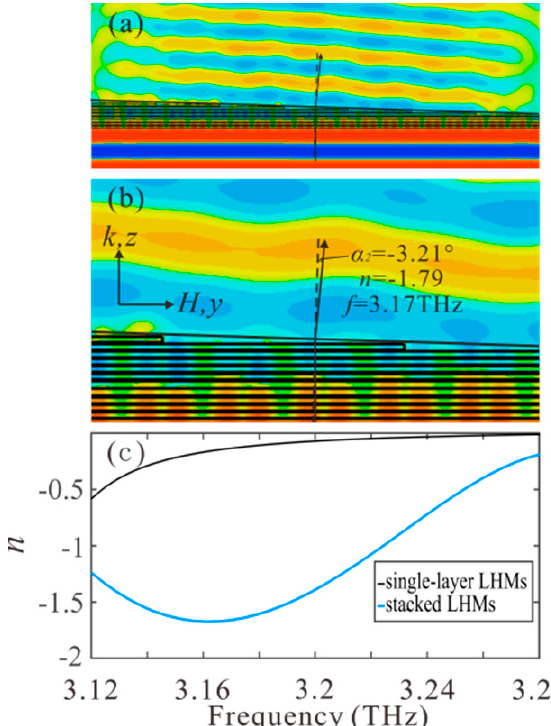
Figure 5. ( a ) E x distribution and ( b ) the local area magnified view for a 3.17 THz normal incident wave (the electric field along the x-direction) from the bottom. ( c ) The calculated refractive indices of stacked LHMs (blue line) and single-layer LHMs (black line).